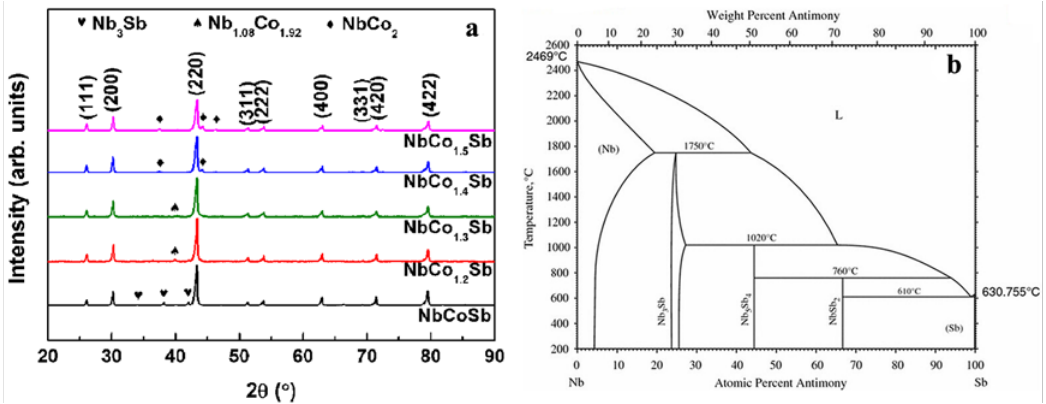
Figure 1. XRD patterns of bulk NbCo 1+ x Sb ( x = 0, 0.2, 0.3, 0.4, 0.5) samples ( a ) the binary phase diagram of Nb and Sb ( b ).